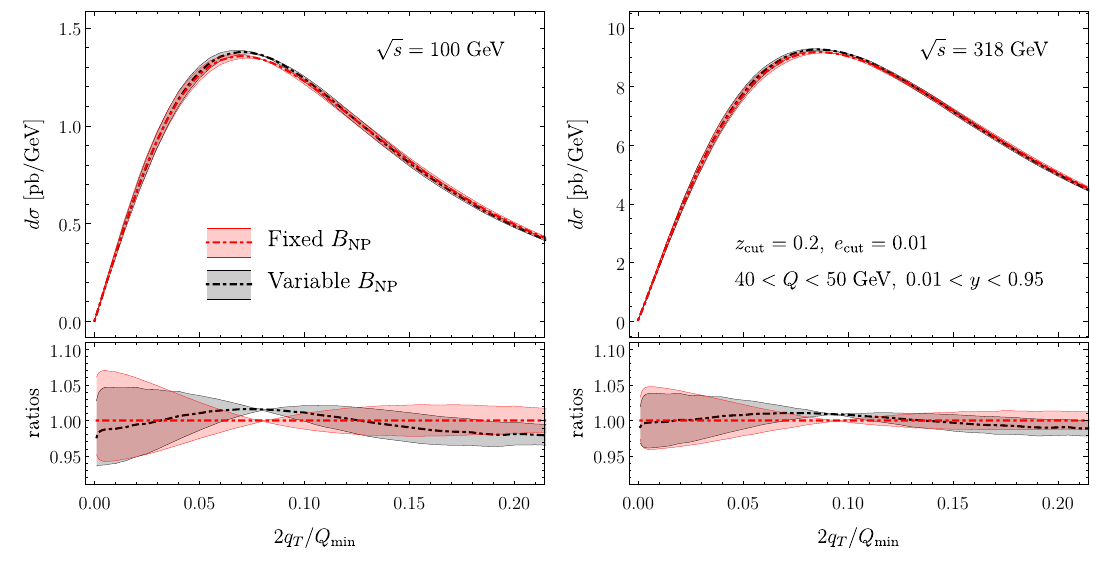
Figure 8 . The NNLL cross-section including modeling of the initial hadronic state effects fitted from Derll-Yan processes using two different scenes: fixed and variable B